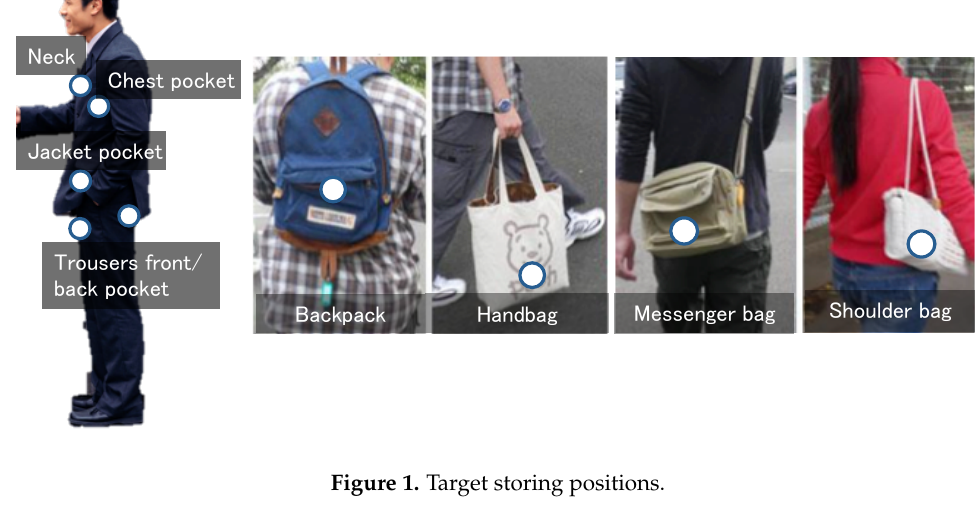
Figure 1. Target storing positions.